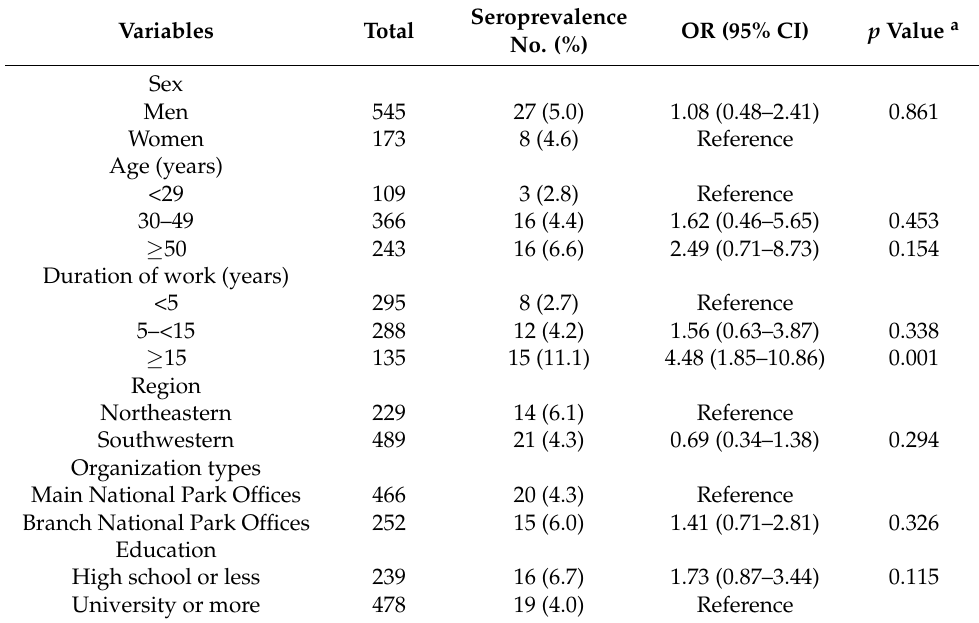
Table 2. Association between demographic characteristics and scrub typhus seroprevalence among National Park Office forestry workers in South Korea.